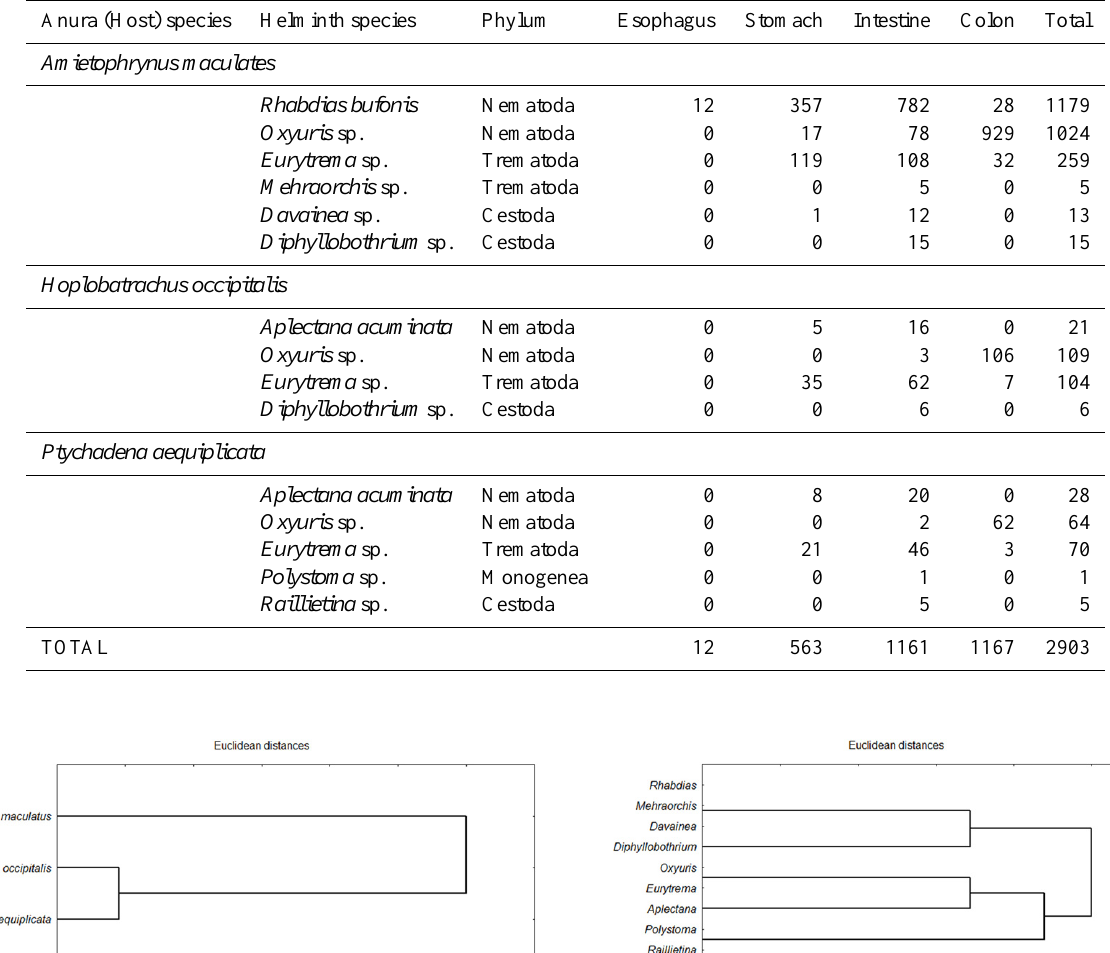
Table 1. Summary of the numbers of helminthes extracted from di ff erent segments of the anuran guts in three species from Port Harcourt, Nigeria.